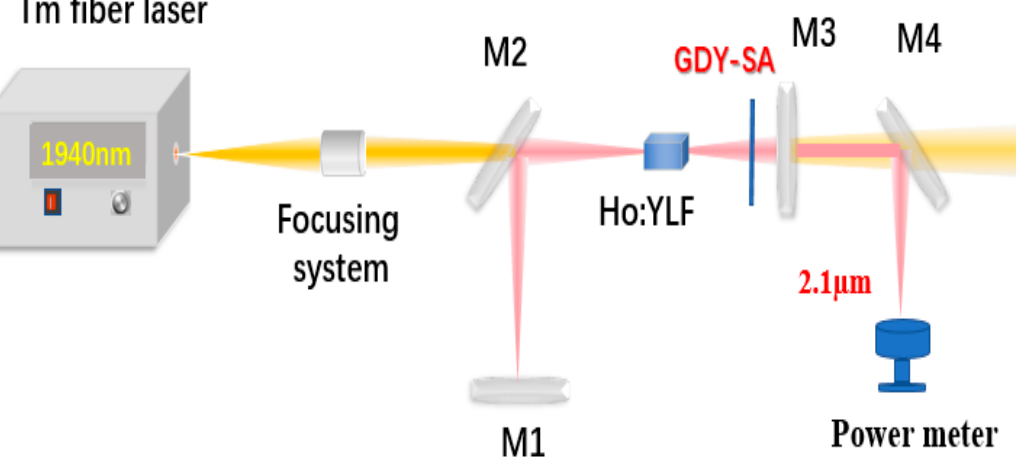
Figure 3. The schematic of the experimental setup for the passively Q-switched (PQS) operation.